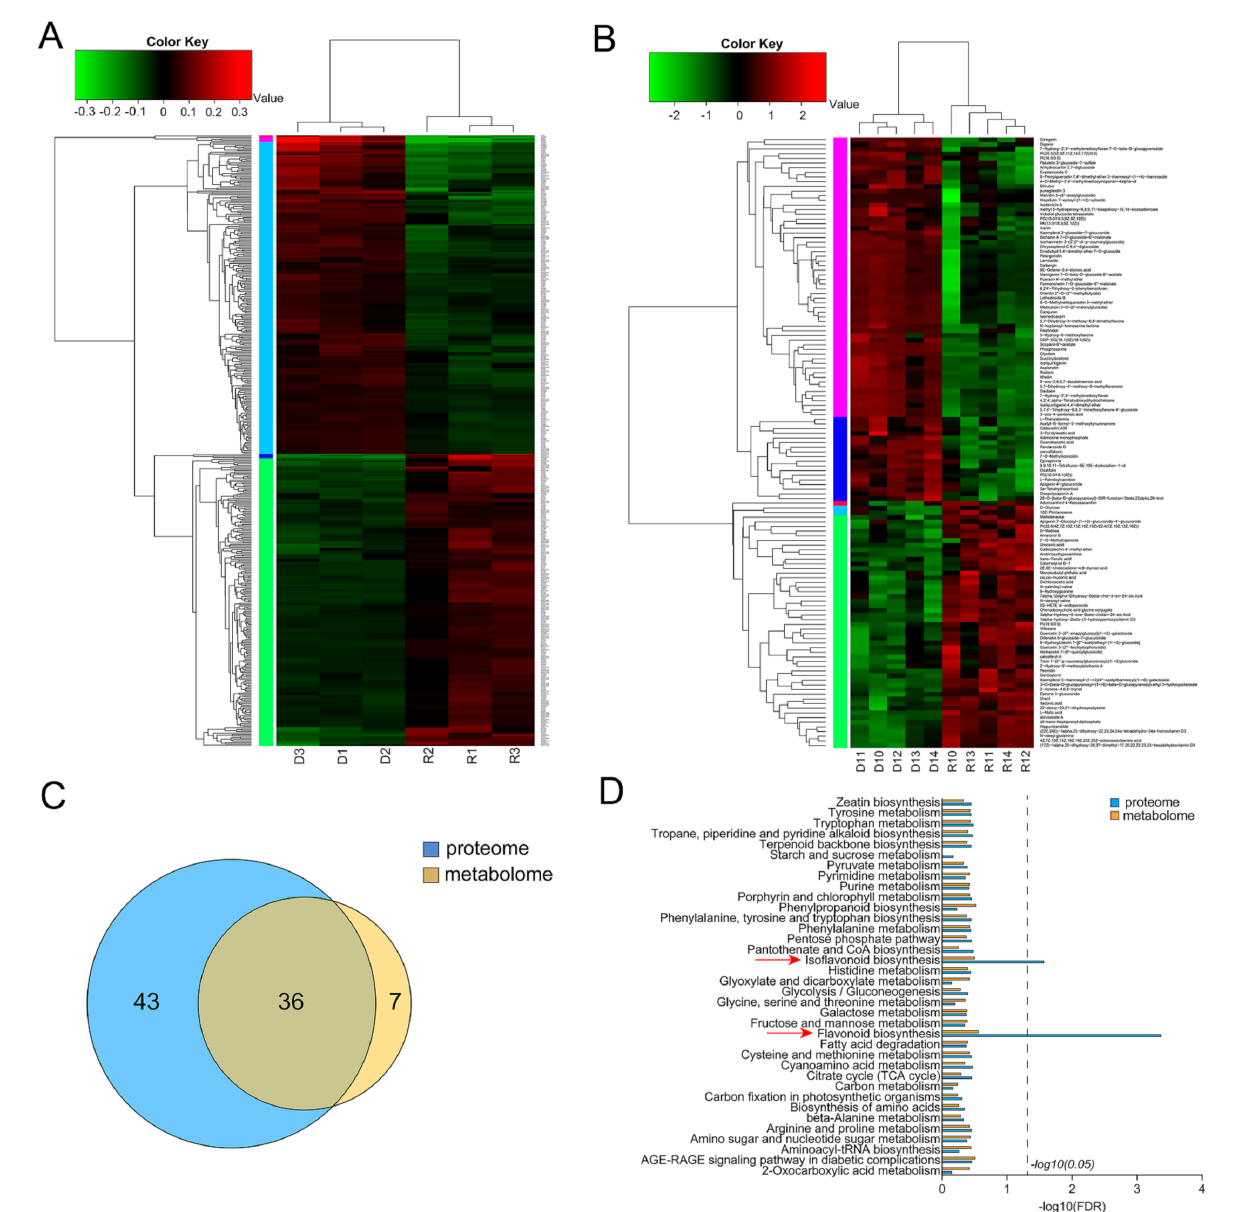
Figure 4. Proteomic and metabolomic analysis of wild-type R108 and ga3ox1 mutant leaves. ( A ) The heatmap of differentially enriched proteins (DEPs) identified by proteomics. ( B ) The heatmap of differential metabolites identified by metabolomics. ( C ) Venn diagram of KEGG pathways enriched by differential proteins and metabolites. ( D ) The histogram of KEGG enrichment of differential